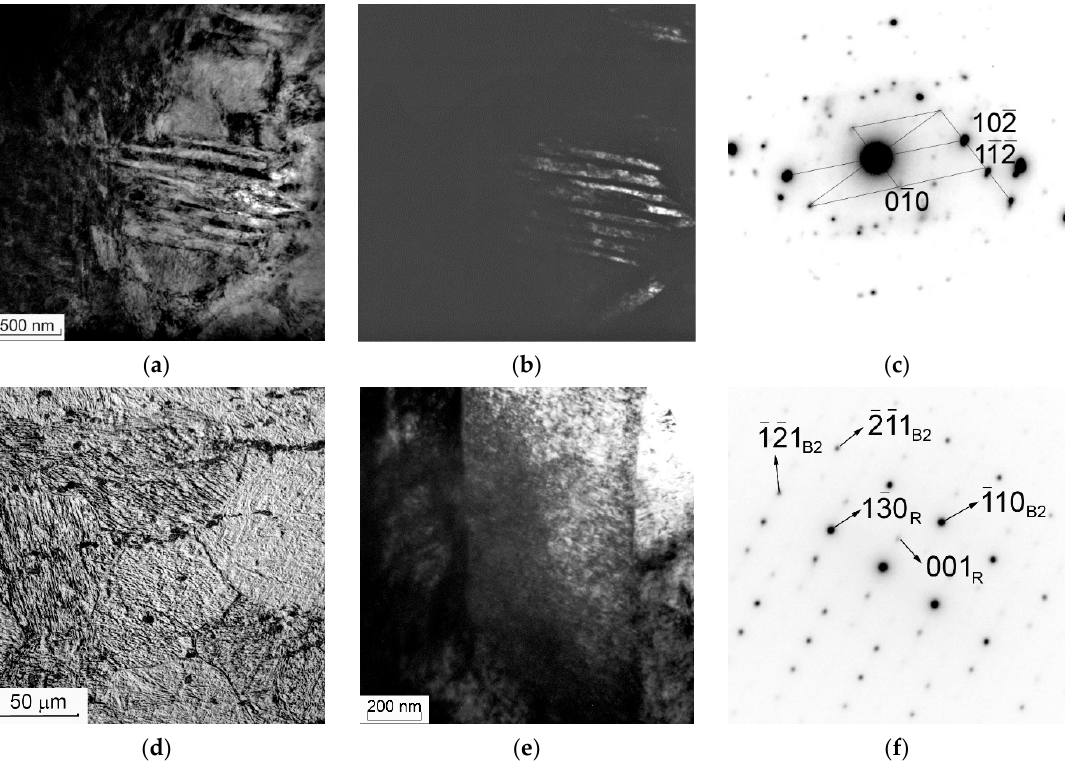
Figure 2. Microstructure of Ti 49.8 Ni 50.2 before abc pressing: ( a – c ) TEM images and respective diffraction pattern of region with В 19’ phase; ( d ) optical image in DIC (Differential Interference Contrast) mode; ( e , f ) TEM images and respective diffraction pattern of region with B2 and R phases.